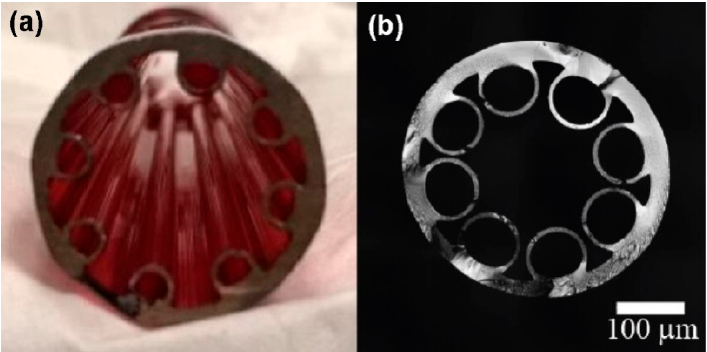
Figure 10. ( a ) The preform made by extrusion technique of As 2 S 3 glass; and, ( b ) The drawn As 2 S 3 RF [50].